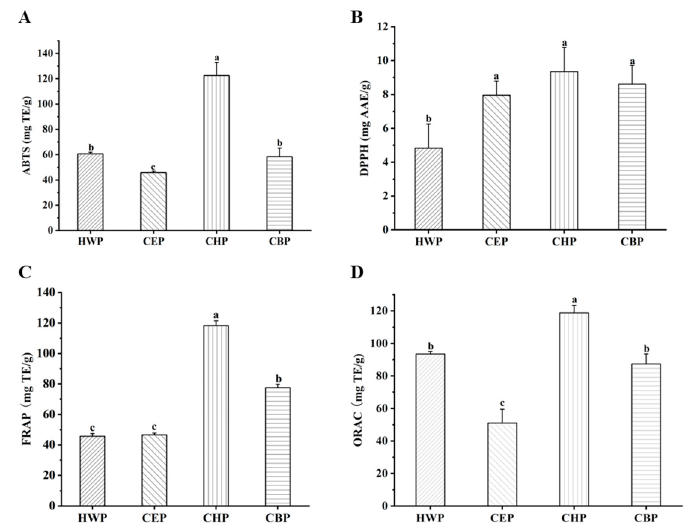
Figure 2. Antioxidant activity determined by ABTS ( A ), DPPH ( B ), FRAP ( C ), and ORAC ( D ) assays of TPs after extraction by different methods. Statistical significance ( p < 0.05) was indicated with different lowercase letters within each subfigure.